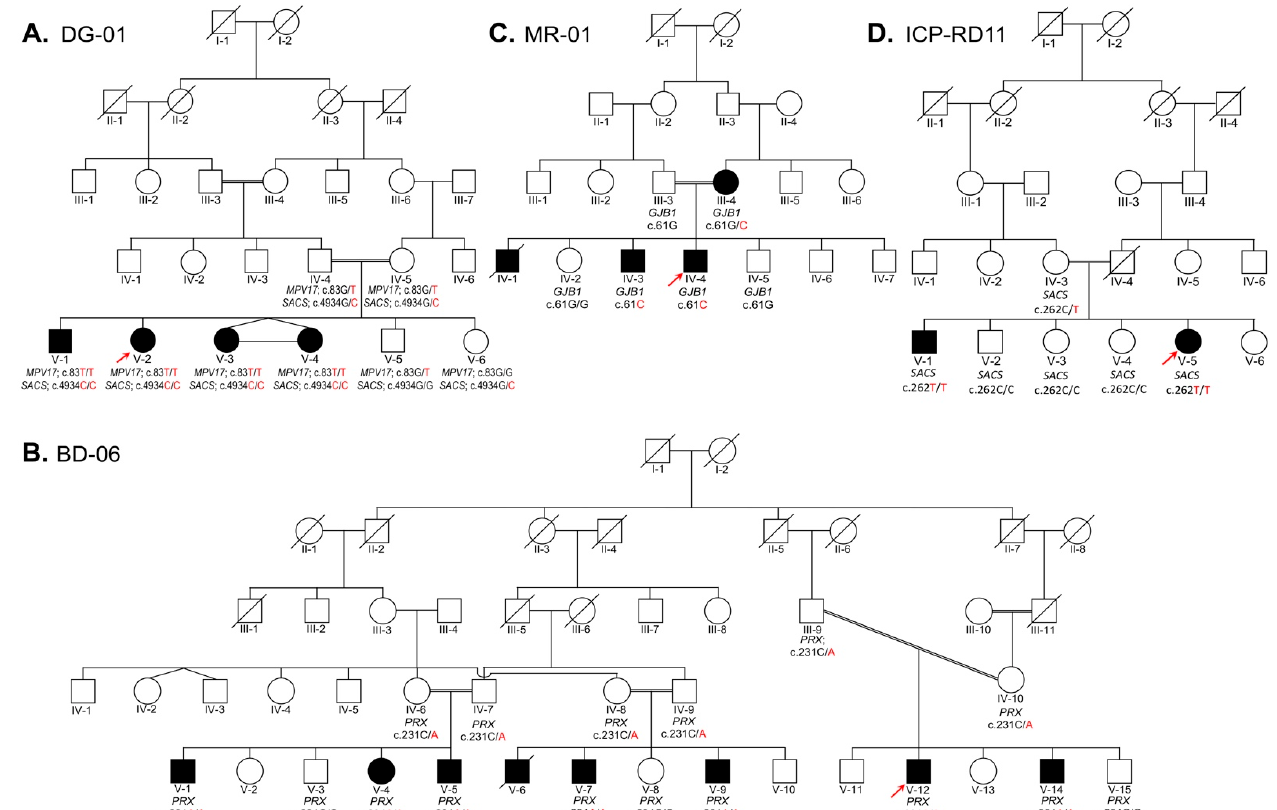
Figure 1. Four families designated as DG-01 ( A ) , BD-06 ( B ), MR-01 ( C ) , and ICP-RD11 (D) are presented here. Family ( A ) segregates two conditions: autosomal recessive CMT type 2EE and autosomal recessive ARSACS. Family ( B ) segregates autosomal recessive CMT Type 4F, while family ( C ) segregates X-linked dominant CMT. Family ( D ) segregates autosomal recessive ARSACS. In each family, the index patient is indicated with an arrow. The genotypes of the family members are written below their symbols, whose samples were available for Sanger sequencing. ( A ) DG-01: In the five-generation pedigree, the four af- fected siblings (V-1, V-2, V-3, and V-4) are homozygous mutants for both MPV17 c.83G>T and SACS c.4934G>C, while one unaffected sibling (V-5) is homozygous wild type for MPV17, and another unaf- fected sibling (V-6) is homozygous wild type for SACS . Their parents (IV-4 and IV-5) are heterozygous carriers for MPV17 c.83G>T and SACS c.4934G>C. ( B ) BD-06: A five-generation pedigree presents the disease in three different clades. Each clade was confirmed for the variant in PRX , and Sanger sequencing was carried out and confirmed that affected individuals (V-1, V-4, V-5, V-7, V-9, V-12, and V-14) are ho- mozygous mutants, while parents (IV-6, IV-7, IV-8, IV-9, III-9, and IV-10) are heterozygous carriers, and normal siblings (V-3, V-7, V-15) are homozygous wild type for PRX c.231C>A. ( C ) MR-01: In a four-gen- eration pedigree, the two affected siblings (IV-3 and IV-4) are hemizygous mutants, while one unaffected sibling (IV-5) and the father (III-3) are homozygous wild type, and the mother (III-4) is a heterozygous carrier for GJB1 : c.61G>C variant. ( D ) ICP-RD11: In a five-generation pedigree, the two affected siblings (V-1, V-5) are homozygous for the mutant allele, while three unaffected siblings (V-2, V-3, and V-4) are homozygous for the wild type allele and their mother (IV-3) is heterozygous carrier for the SACS c.262C>T variant. 2.2. Genomic DNA Extraction and Genetic Analysis Genomic DNA was extracted from all available family members’ blood using PureLinked ® genomic extraction kits (Thermo Fisher, Waltham, MA, USA). DNA quantity and quality were analyzed using a Nanodrop 1000 spectrophotometer (Thermo Fisher, Wal- tham, USA). WES was planned for the index patients in each family for the genes involved in axonal motor sensory neuropathies (Supplementary Table S1). The exome, which covers about 22,000 disease-causing human genes, was captured using xGen Exome Research Panel v2 (Integrated DNA Technologies, Coralville, IA, USA) [34,35]. The captured exome was se- quenced using NovaSeq 6000 (Illumina, San Diego, CA, USA) with a mean depth of coverage